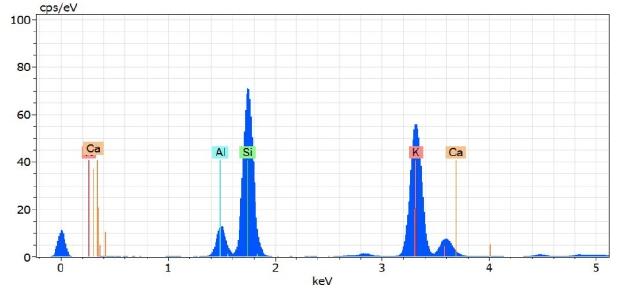
Figure 1. µ-EDXRF spectrum of a K feldspar with the main con- stituents: Al (1.04keV), Si (1,7keV) and K (K α : 3,3keV, K β :